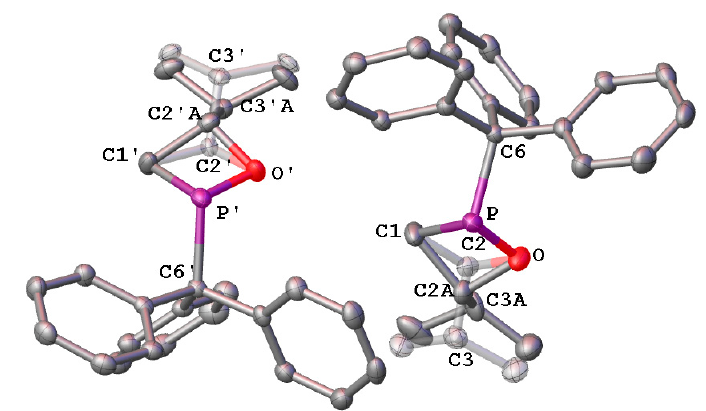
Figure 2. Molecular structures of 1,2-oxaphosphetane 4b,b’ in the solid state. Hydrogen atoms are omitted and the thermal ellipsoids are set at the 50% probability level. Split layers C2A:C2 equals 33:67, C2 ′ A:C2 ′ equals 45:55. Selected bond lengths in Å, angles in degree, second entry corresponds to the crystallographic positions denoted with a dash: P-O 1.6792(14)/1.6803(13), P-C1 1.854(2)/1.849(2), P-C6 1.9229(19)/1.9148(18), O-C2 1.538(3)/1.542(3), O-C2A 1.451(6)/1.477(4), C1-C2 1.562(3)/1.599(4), C1-C2A 1.609(7)/1.552(5), O-P-C1 79.93(8)/80.07(8), C2-O-P 96.67(13)/97.70(13),